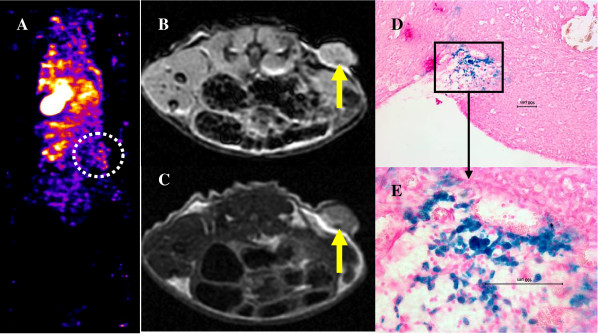
Accumulation of magnetically labeled, non-transgenic APCs around the implanted tumor 7 days after IV administration. (A) Coronal sections of SPECT data indicating non-significant activity of Tc-99m at the tumor site (within the white circular ROI). MRI shows low signal intensity areas at the periphery of the tumor (B, C, arrows), which are at the corresponding sites of iron positive cells detected by Prussian blue staining (D, E).